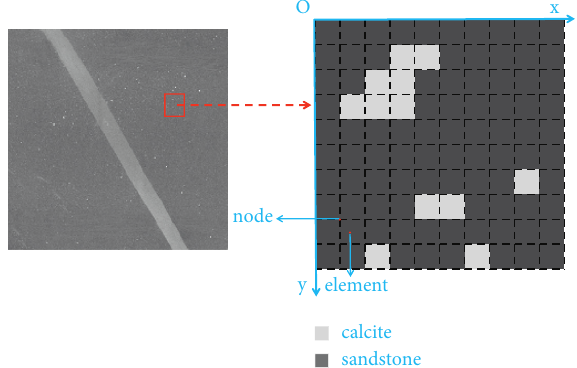
Figure 5: Digital image of sandstone and its finite element mesh